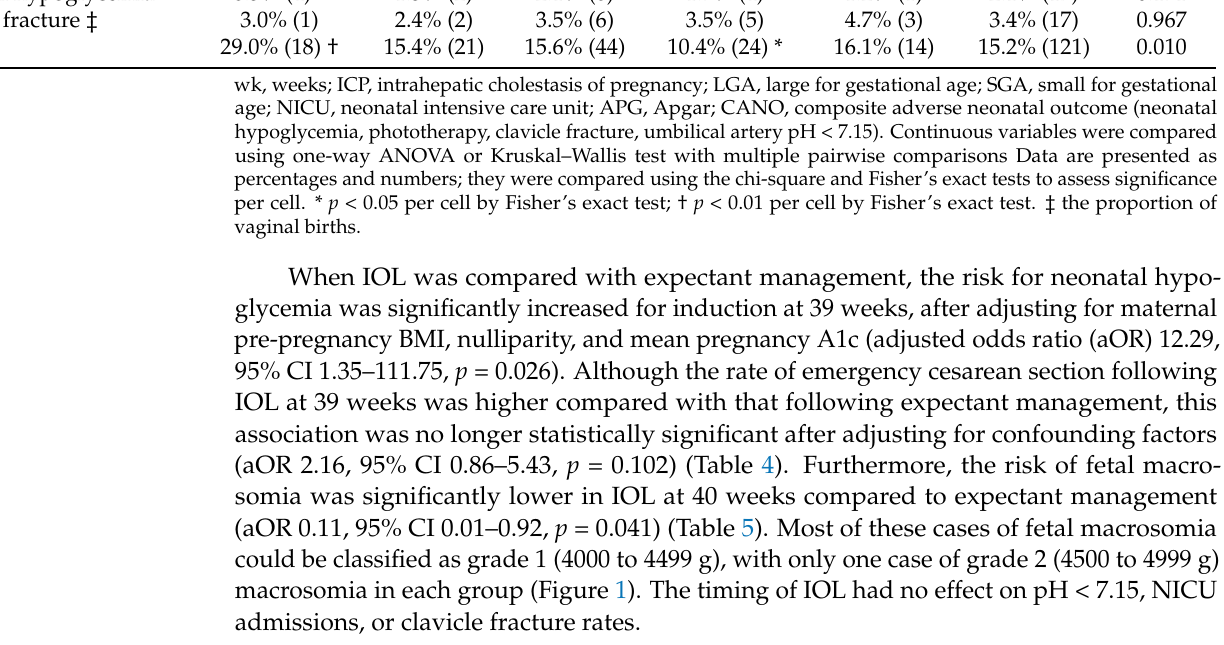
Table 4. Induction of labor at 39 weeks vs. Expectant